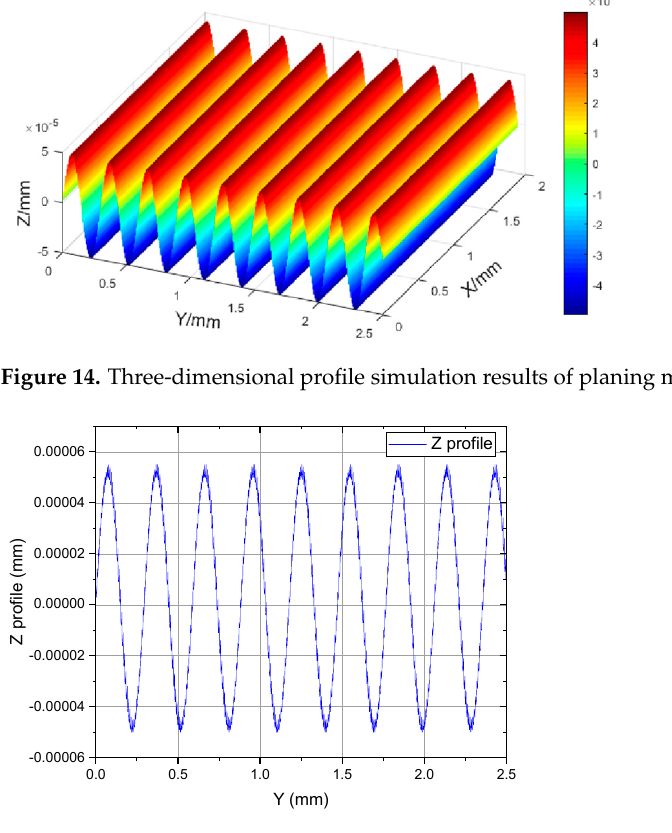
Figure 15. Two-dimensional profile of simulation results in the feed direction.